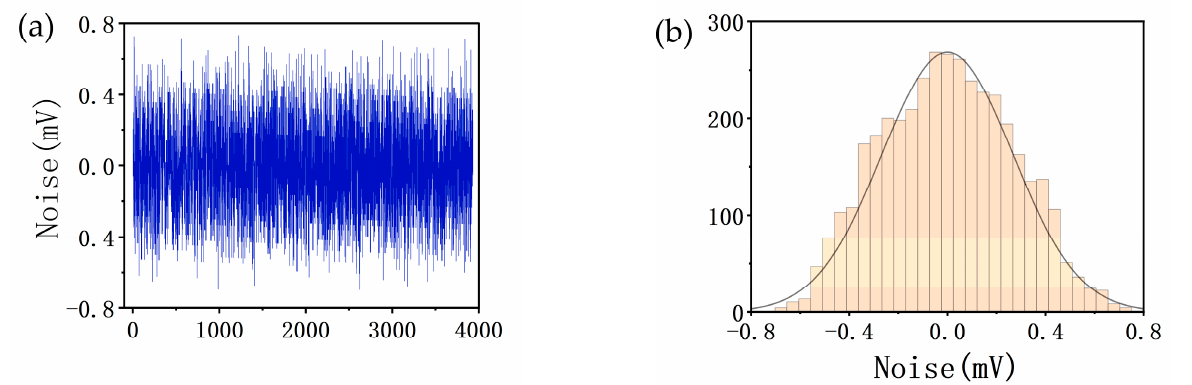
Figure 3. Noise of ADC0: ( a ) Noise waveform (the x -axis represents the collection of 4000 data points) and ( b ) noise distribution interval (the y -axis represents the number of data points distributed at different intervals). Table 1. Noise evaluation of each channel of the ADC.